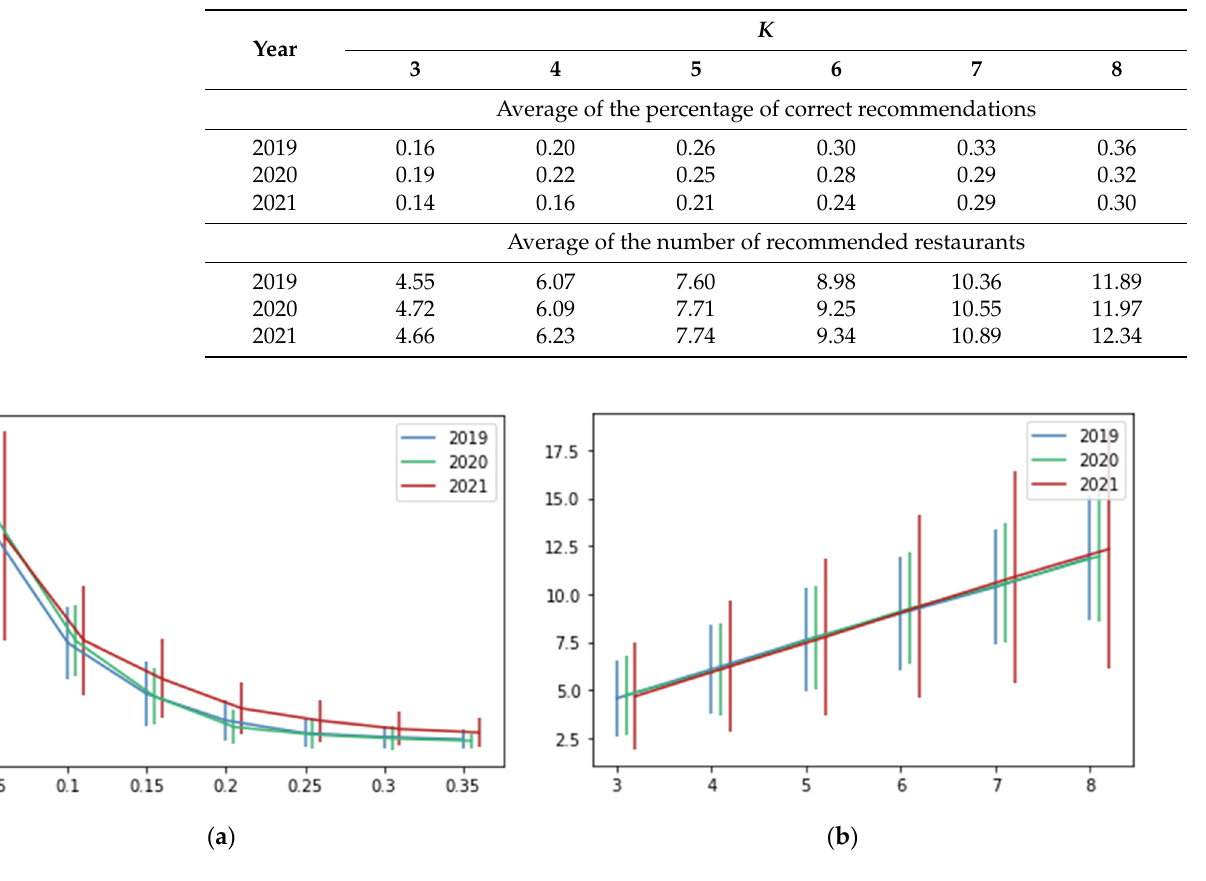
Table 5. Results of our proposed recommendation system according to the value of the parameter k .